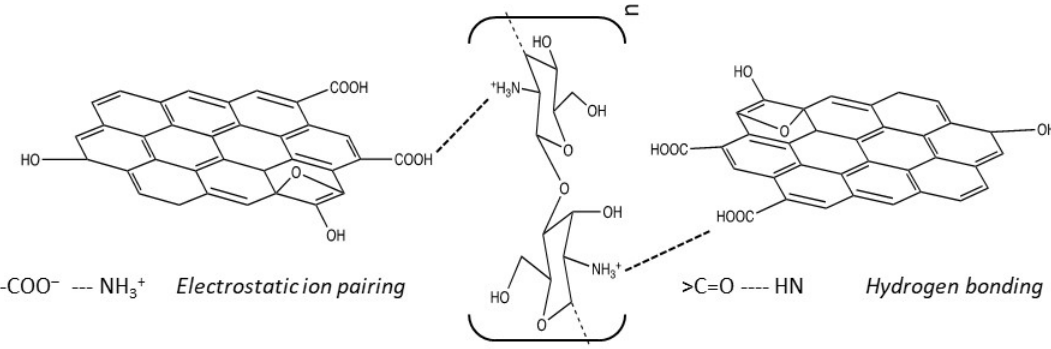
Figure 5. Schematic representation of the interactions between chitosan and